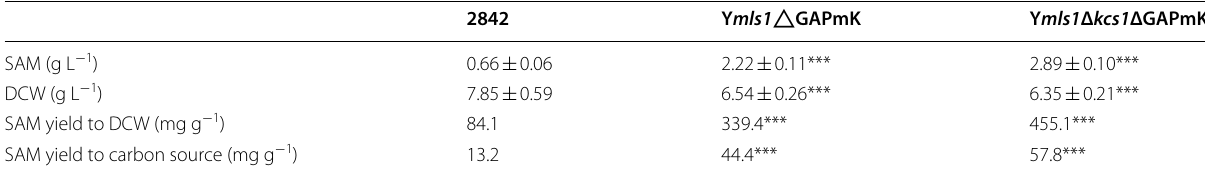
Table 4 Increased glycolysis by deletion kcs1 in the recombinant strain Ymls1Δkcs1ΔGAPmK further improved SAM production